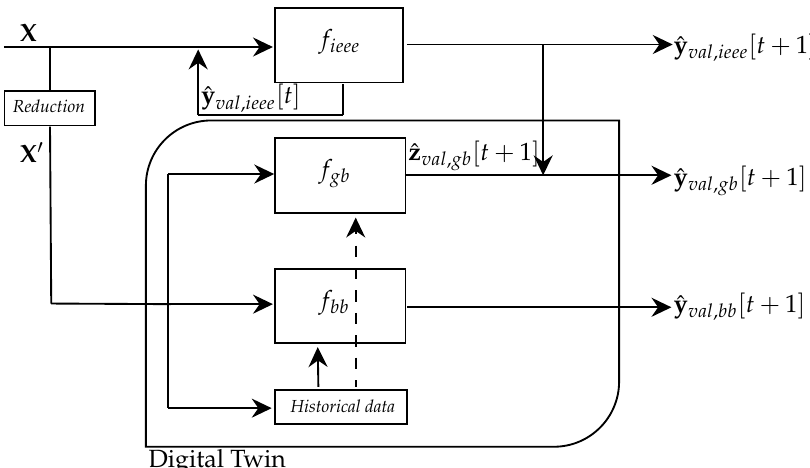
Figure 2. Detailed overview of the proposed Digital Twin